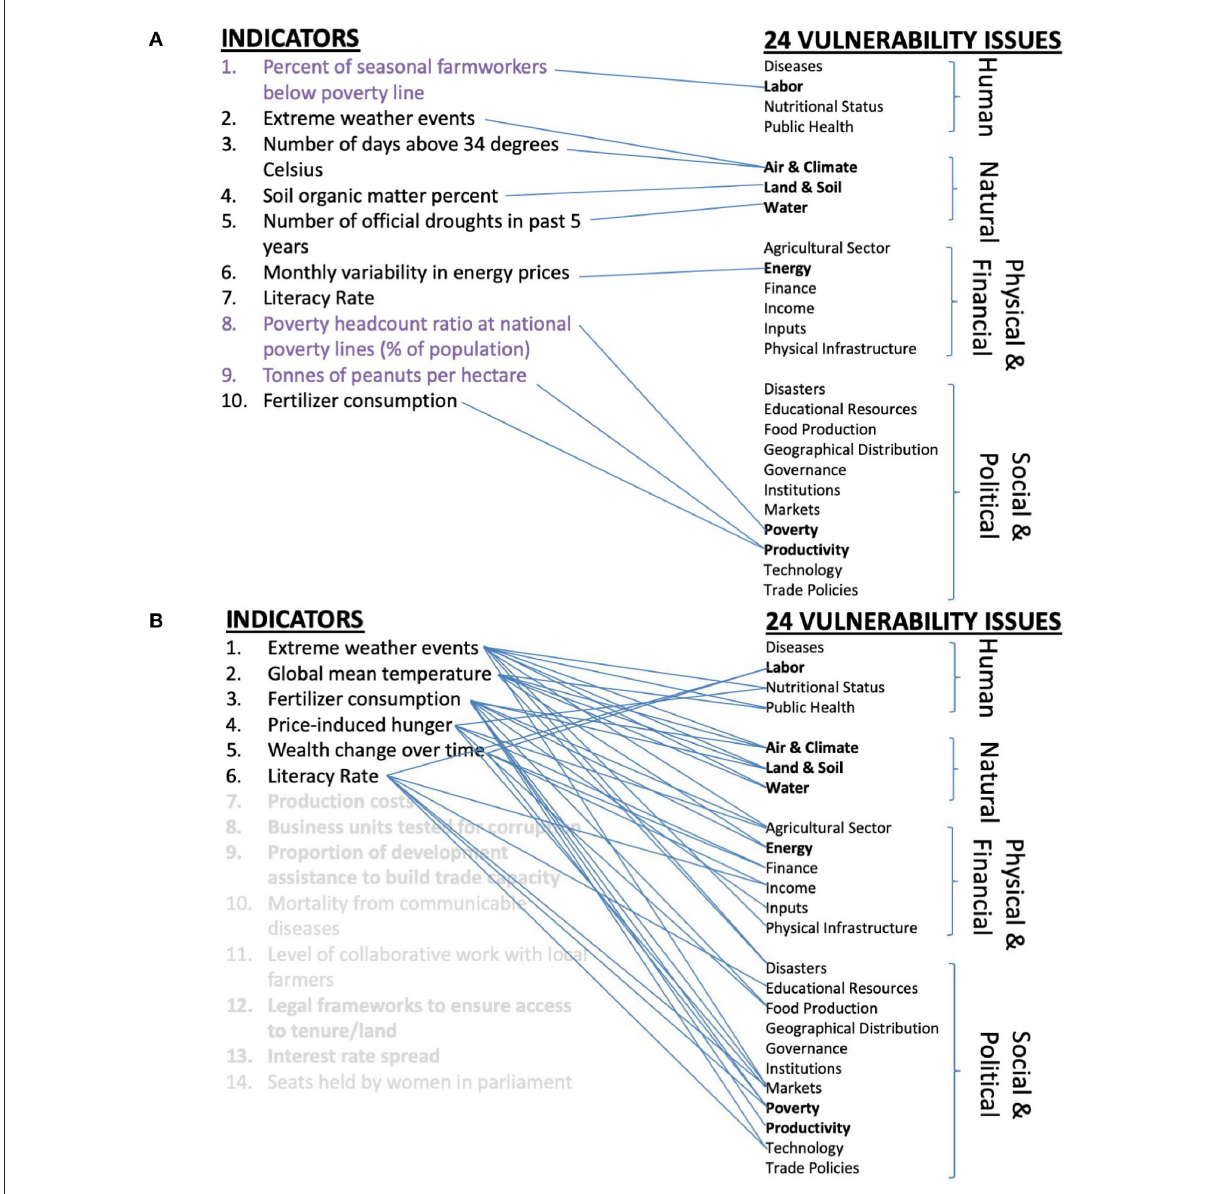
FIGURE3 Beginning of checklist generator process in Case 1 with ten indicators covering seven issues (A) compared to end of checklist generator process with six indicators covering 80% of the 24 relevant vulnerability issues (B) . Indicators highlighted purple are the three indicators added to the graph database by the stakeholder group, bolded issues are the initial issues covered by the food company, and the grayed-out indicators are those covering the remaining 20% of